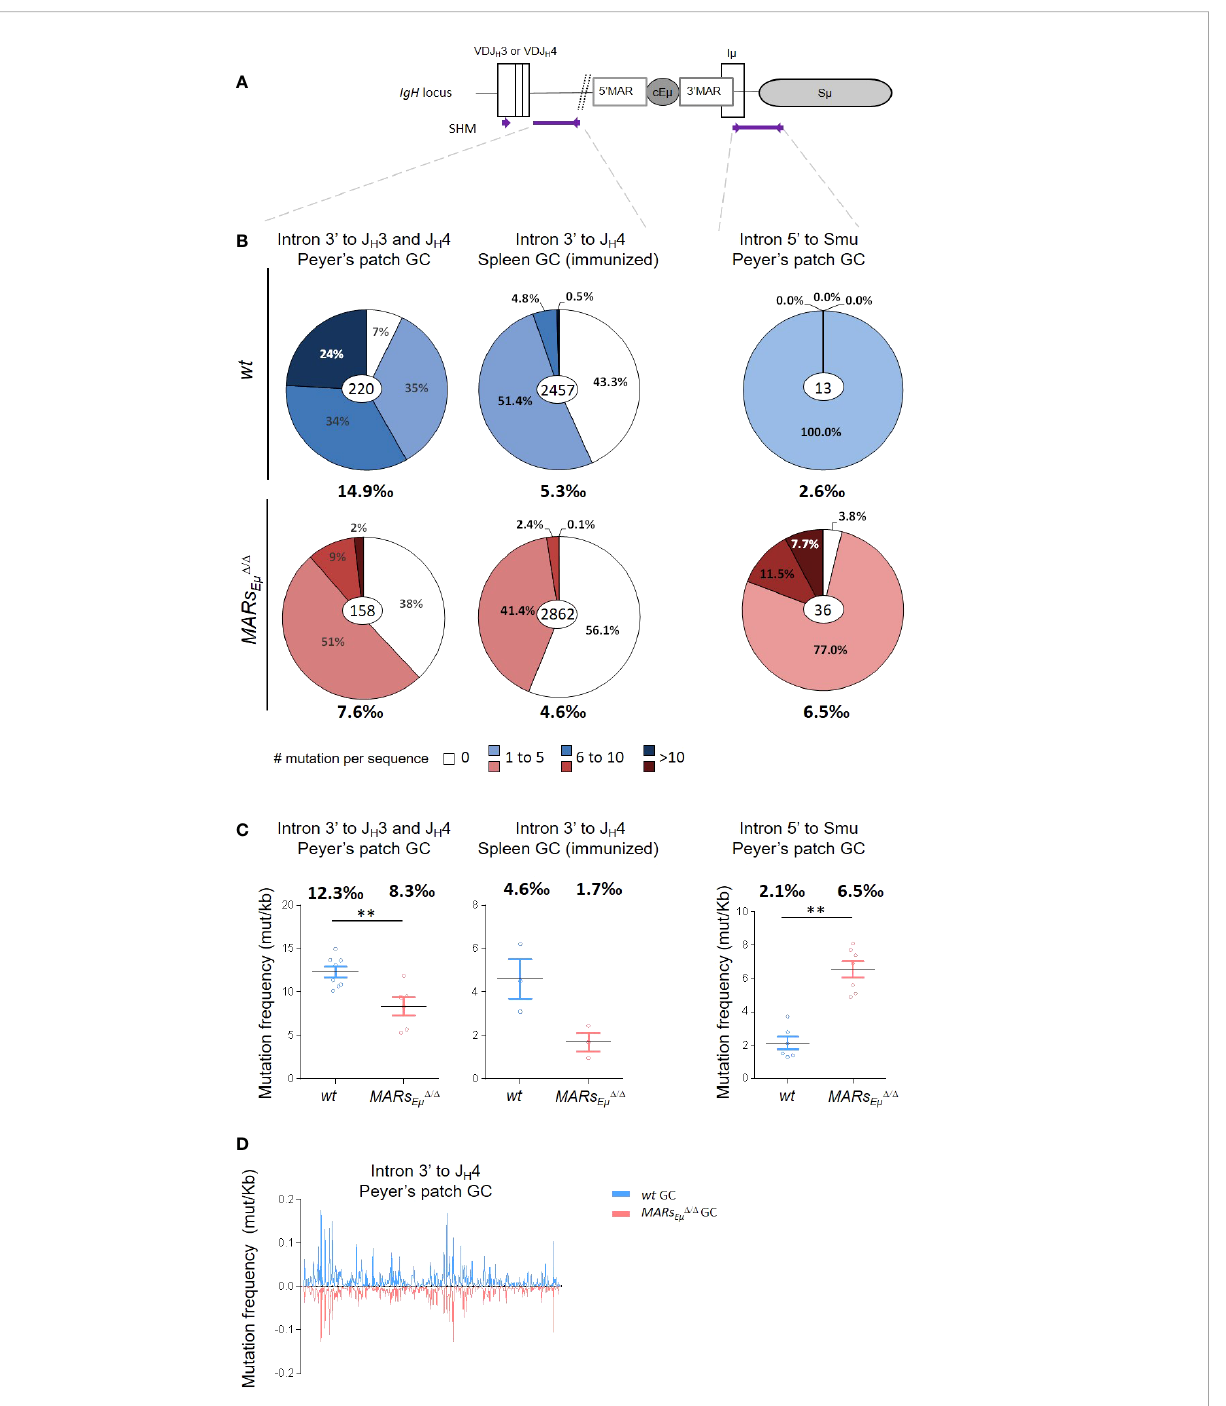
FIGURE 2 MARs Eμ deletion impairs the overall SHM frequency and distribution within the IgH J-C intronic region. (A) Location of IgH regions (thick purple lines) tested for SHM, arrows represent primers used for PCR ampli fi cation. (B) Pie charts represent distribution of mutated sequences (proportional to the area in each slice, data obtained by Sanger and GS Junior sequencing method) quanti fi ed in wt and MARs Eμ D / D mice in individually recombined IgH alleles. For each genotype number of individual clones is indicated in the center (after removal of clonally related sequences based on VDJ junction) and overall mutation frequencies (mutation per 1000 bp in mutated clones) are indicated below. Left: SHM downstream from J H 3 and J H 4 segments in Peyer ’ s patch sorted GC B cells, data obtained after cloning and sequencing by classical Sanger method. Middle: SHM downstream from J H 4 segments in spleen GC B cells sorted from SRBC-immunized mice, data obtained by NGS (GS Junior). Right: SHM downstream from cEμ region from Peyer ’ s patch GC sorted B cells, data obtained by classical Sanger method. (C) Graphical representation of SHM frequency in wt and MARs Eμ D / D mice, quanti fi ed by NGS (Ion Proton) submitted to DeMinEr fi ltering, a pipeline that identi fi es substitution frequency at each nucleotide based on an Aicda D / D control sample (28). Since no indication in sequence distribution is available using this method, data were represented as scattered plots, each point refers to a mutation frequency from one individual mice, mean mutation frequencies are indicated above. p-value was determined with two tailed Mann Whitney test; signi fi cant differences are indicated by: **P < 0.01 and error bars represent SEM of two independent experiments. (D) Mutation distribution along the J H 4 intron in wt (top) and in MARs Eμ D / D